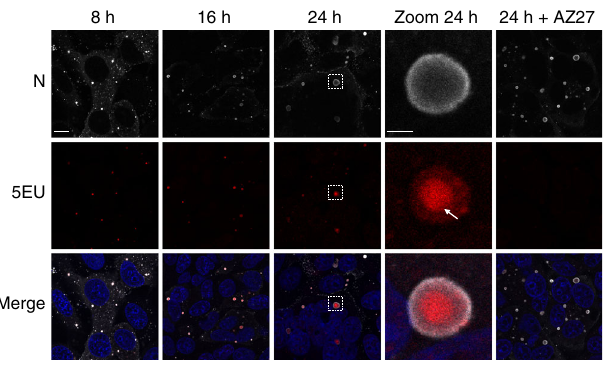
Fig. 1 Localization of newly synthesized viral RNA in RSV-infected cells. HEp-2 cells were infected with RSV. Two hours before the indicated times p.i. cells were incubated for 1 h with actinomycin D to inhibit cellular transcription and then 5-ethynyl uridine (5EU) was added for 1 h before cells were fi xed. RSV polymerase inhibitor (AZ27) was added 6 h prior actinomycin D incubation. The 5EU incorporated in newly synthesized RNAs was detected using Alexa Fluor 647-azide ( red ) and cells were stained with an anti-N antibody ( gray ) and Hoechst 33258 (merge). Representative images from three independent experiments are shown. Images were taken under a Leica SP8 confocal microscope at different times p.i. as indicated. Scale bar 10 µ m. The boxed areas enclose IBs that are shown magni fi ed (zoom), scale bar 2 µ m. White arrow indicates a 5EU